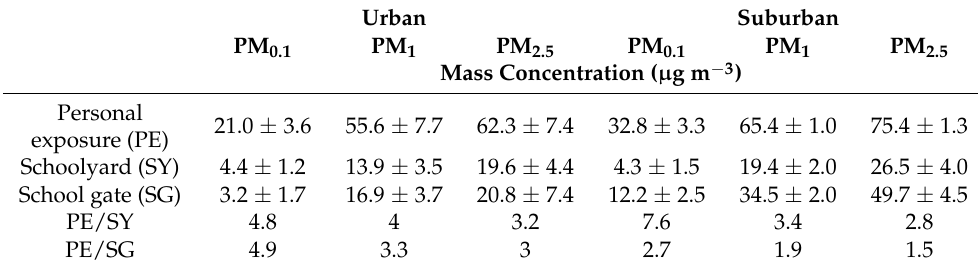
Figure 5. Size-resolved particle (PM 0.1 , PM 1 , and PM 2.5 ) concentrations based on schoolchildren’s school of origin: personal exposure vs. in ambient schoolyard (SY) and school gate (SG). Table 6. Average mass concentrations of PMs: personal exposure vs. school environments.